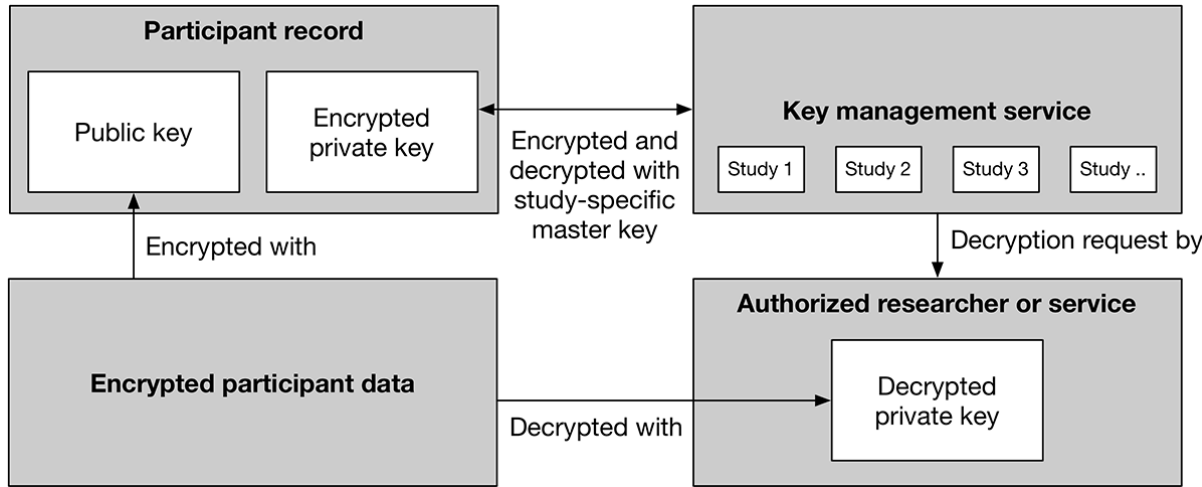
Figure 4. Three-step encryption model: (1) load a participant-bound encrypted private key, (2) request a decrypted version of the private key from